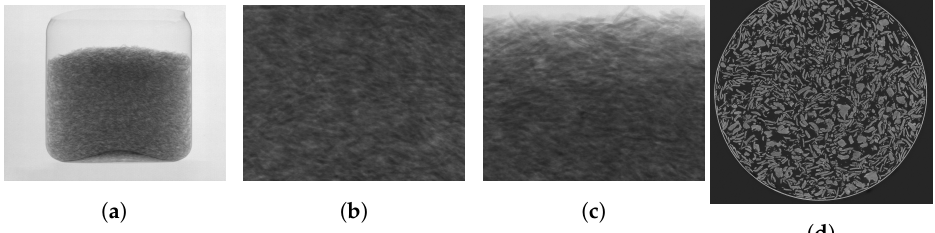
Figure 8. ( a ) A projection image of the oatmeal sample; ( b ) a magnified projection image of the central ROI; ( c ) a magnified projection image of the upper ROI; ( d ) a central slice of the oatmeal sample.